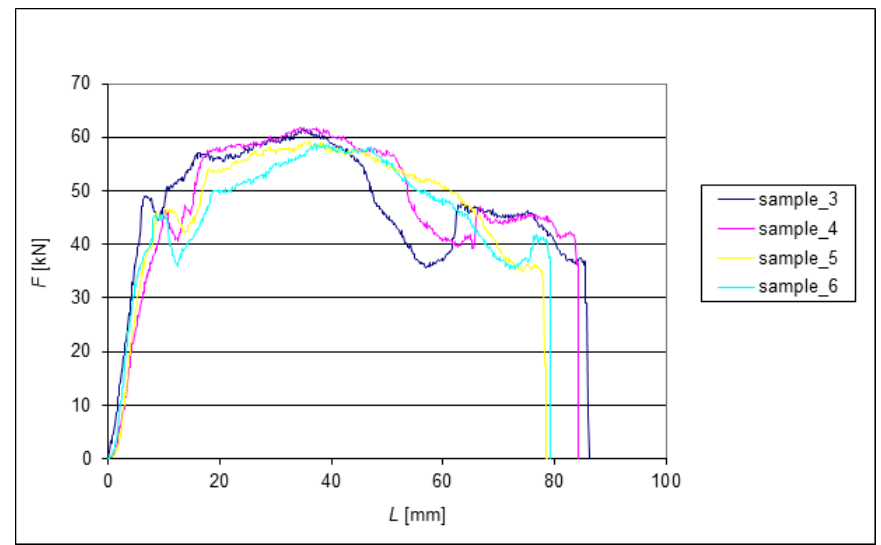
Figure 8. Dependence of the force on the length of extrusion during the third pass through the ECAP die.